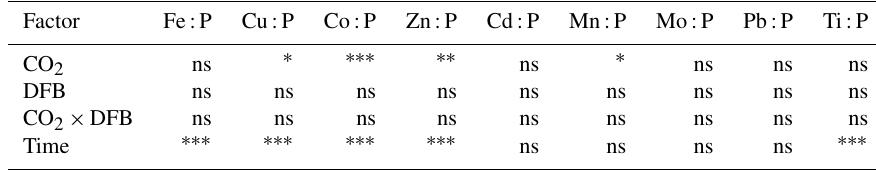
Table 3. Statistical analyses (split-plot ANOVA) of the effects of CO 2 , DFB and their interaction, as well as the effect of time, on the P-normalized metal quotas (mmol : molP; see data in Fig. 2 and Table S2) in particles collected from the different mesocosm treatments. Factor Fe : P Cu : P Co :